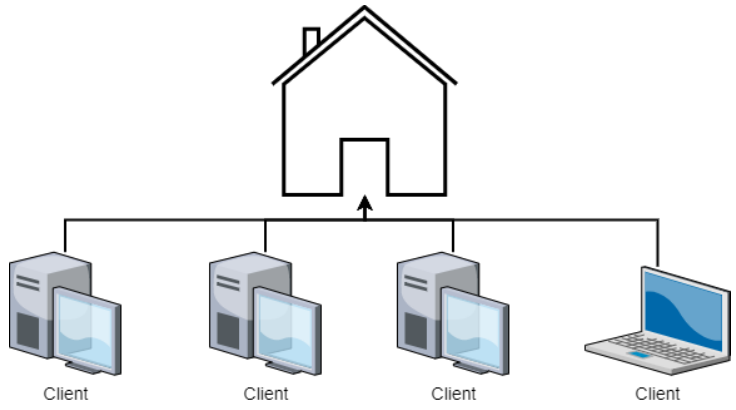
Figure 2. Local Area Network